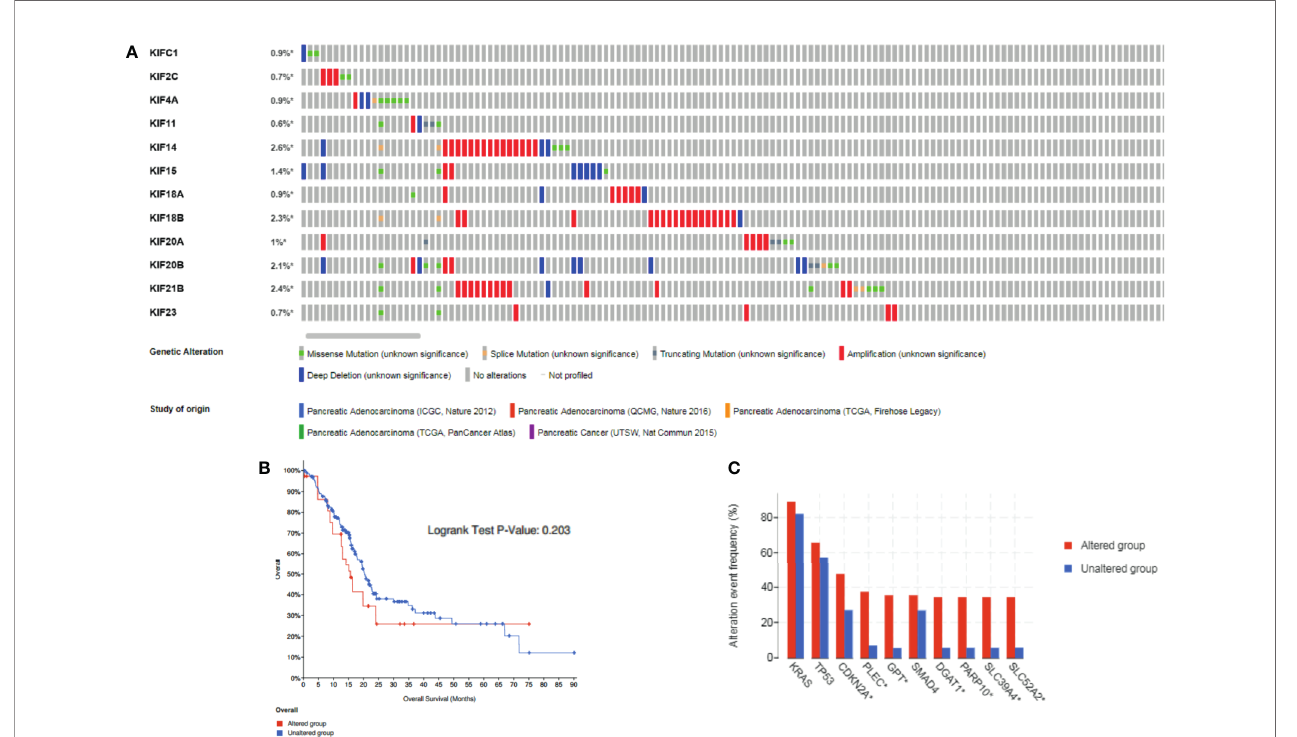
FIGURE 4 | The gene alterations and correlations between prognosis-related KIFs. (A) cBioPortal OncoPrint of prognosis-related KIFs in PAAD cohort of the TCGA dataset. (B) Overall survival of PAAD patients with at least one alteration event of any prognosis-related genes and non-altered patients. (C) Comparison of most frequent gene mutation in PAAD patients with at least one alteration of any KIFs gene compared to non-altered